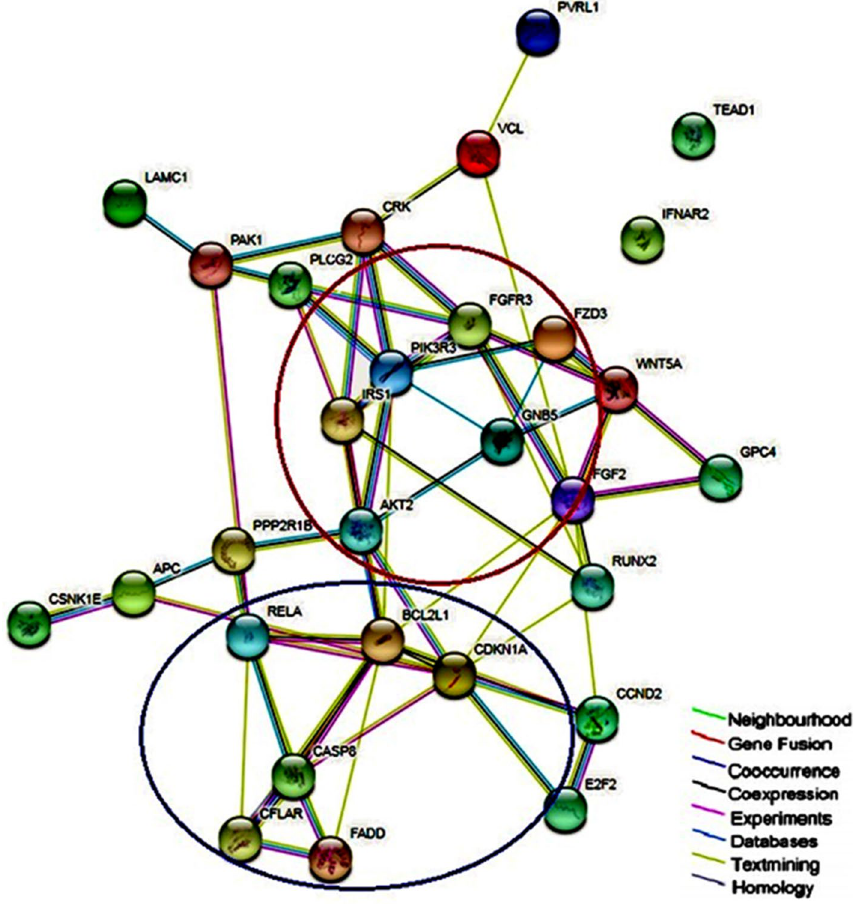
Figure 5. Protein–protein interaction (PPI) network of differentially expressed miRNAs’ target genes. The shortlisted miRNAs targets were subjected to Search Tool for the Retrieval of Interacting Genes (STRING) 10.5 database analyses. STRING constructed a network model showing all protein interactions, which islinked to KEGG and Gene Ontology (GO) databases to cluster the shortlisted genes as the input into pathways and biological